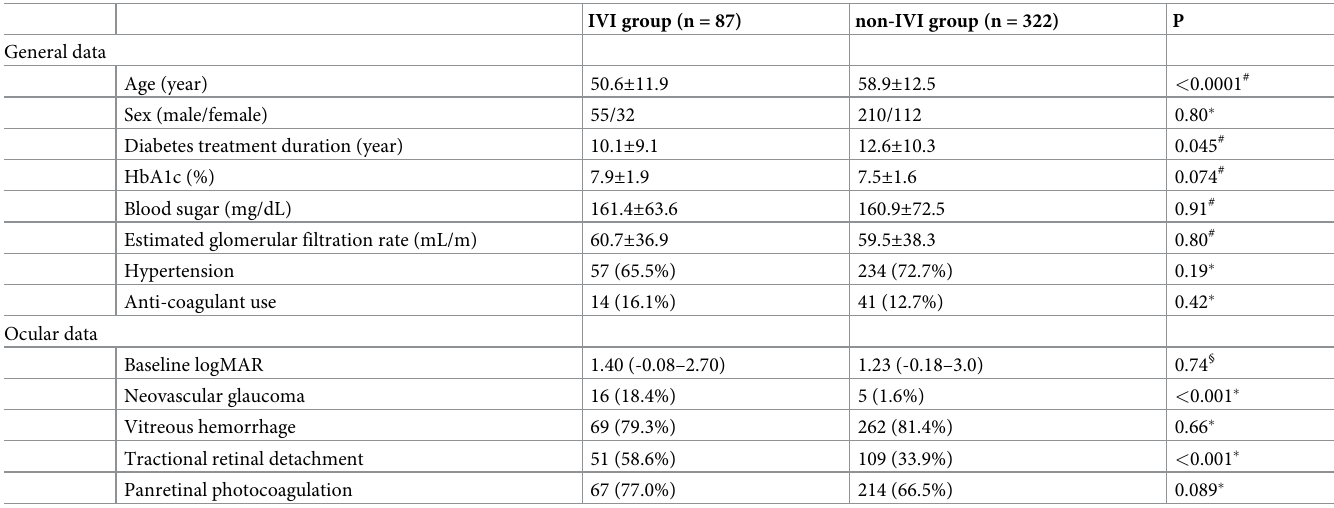
Table 1. General and ocular characteristics at baseline in two groups.